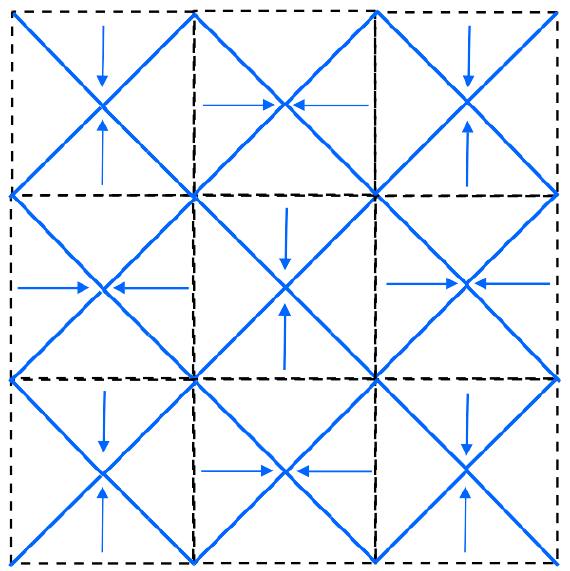
Figure 13. A schematic showing how the grain-boundary faceting can cause the reduction of the grain size. The black dashed lines illustrate the original grain boundaries while the blue solid lines represent the new grain boundaries after faceting. The arrows indicate the movement direction of the